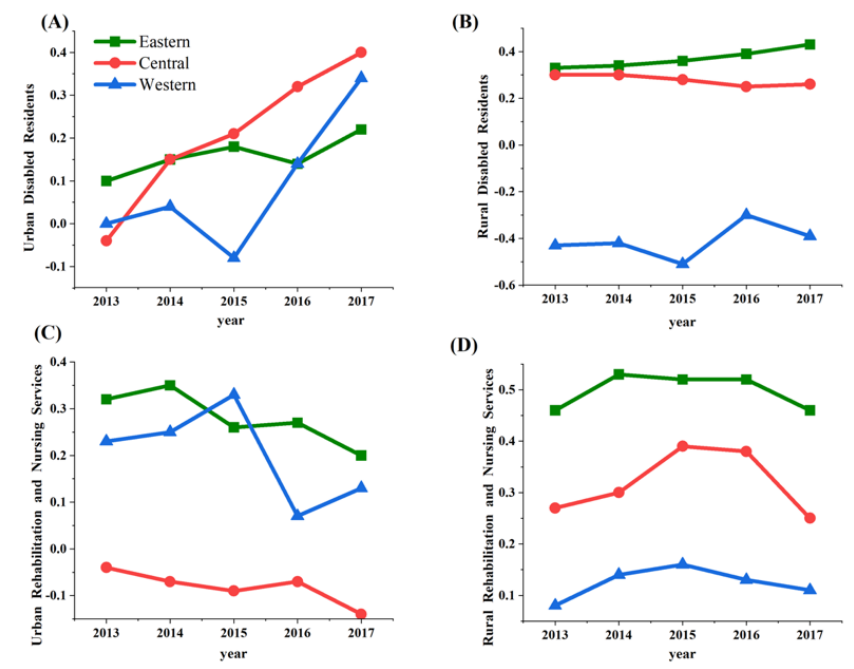
Figure 1. CI for LTC services in the Eastern, Central, and Western economic regions (2013–2017). ( A ) and ( B ) illustrate changes in CI for disabled residents in urban and rural area, respectively; ( C ) and ( D ) illustrate changes in CI for rehabilitation and nursing services in urban and rural area, respec- tively.